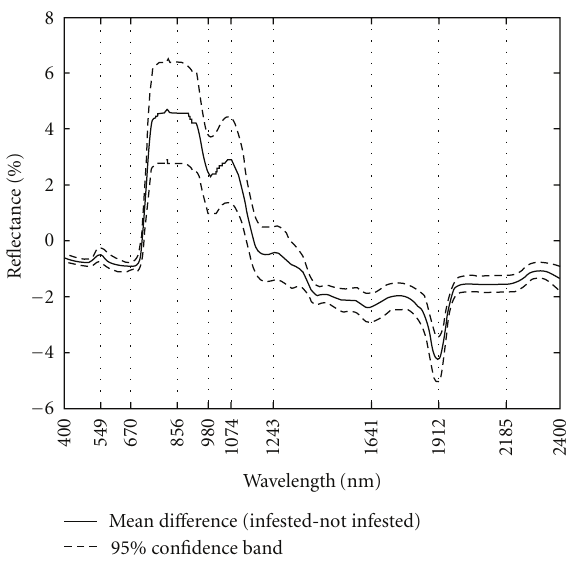
Figure 2: Di ff erence in the mean spectral response (solid line) of subalpine fir trees that were not infested or infested with the balsam woolly adelgid. Dashed lines represent the 95% confidence intervals around the mean. Dotted vertical lines represent the narrow wavebands selected for use in the stepwise discriminant